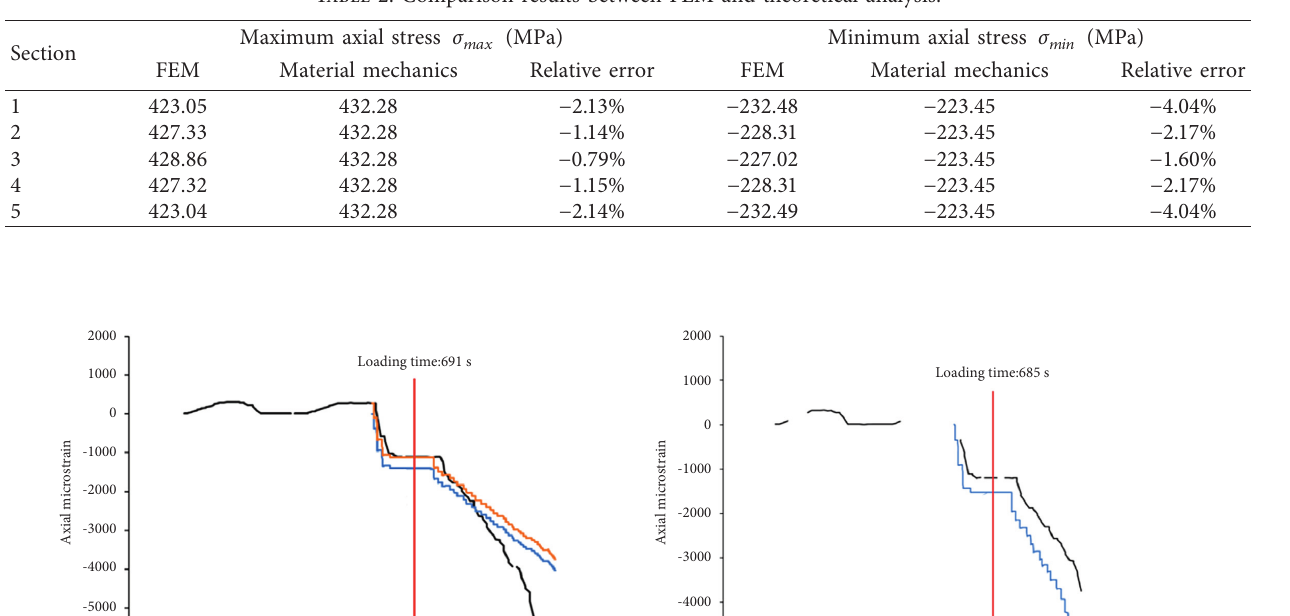
Table 2: Comparison results between FEM and theoretical analysis.